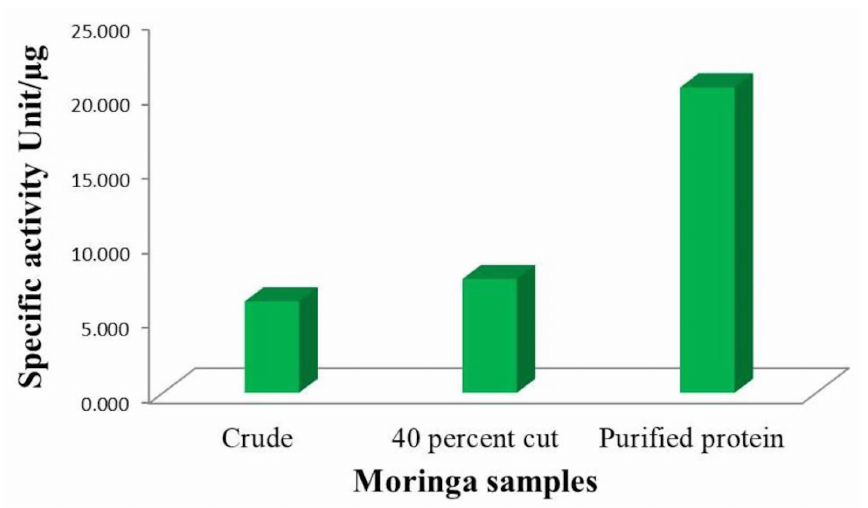
Figure 6. Comparison of specific activity of crude extract, 40% ammonium sulfate fraction and purified protease at optimum pH 8 and optimum temperature 37ºC is represented as a bar diagram. Free tyrosine liberated due to β -casein degradation was measured as described earlier. Enzyme activity present per amount of enzyme is calculated as specific activity of the protease.